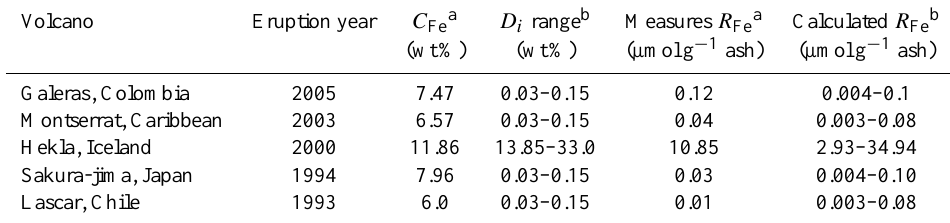
Table 6. Calculated and measured iron release from the volcanic ash surface.